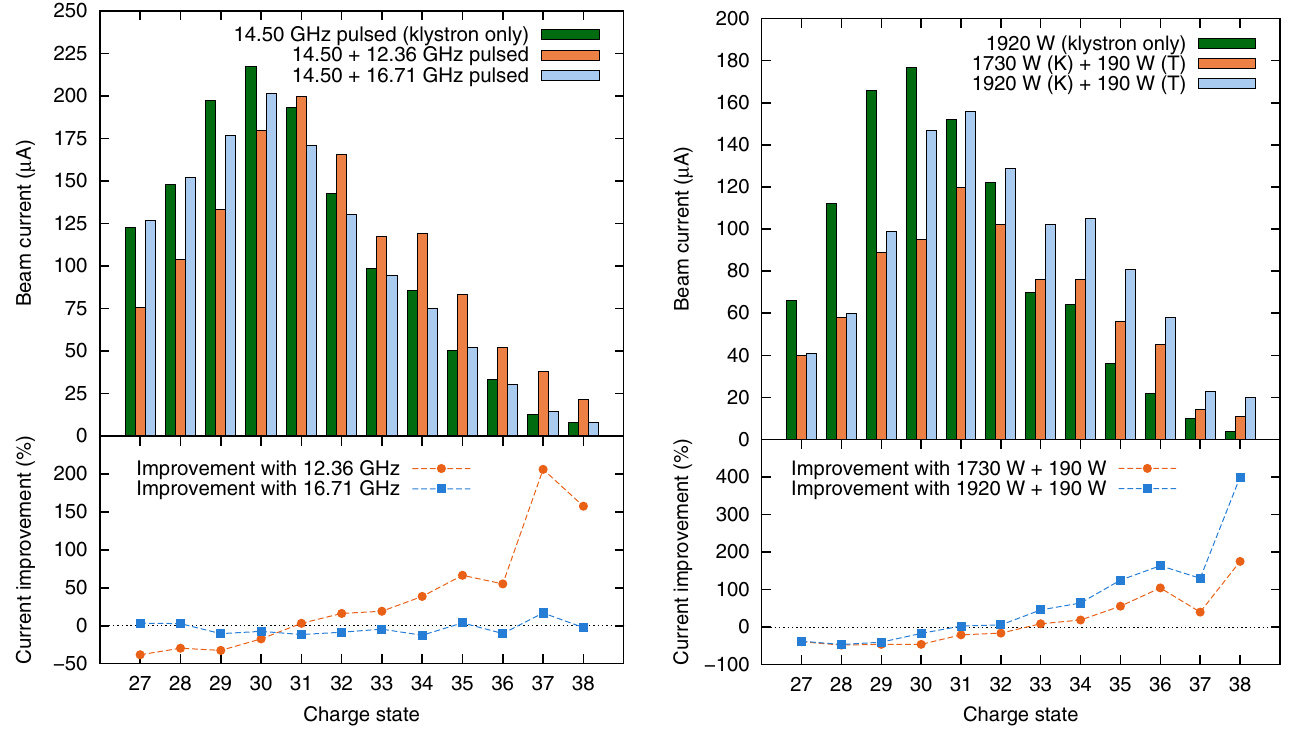
FIG. 10. Lead charge state distribution during afterglow with two different secondary microwave frequencies. Klystron operated at 1920 W, TWTA at 180 and 185 W for 12.36 and 16.71 GHz, respectively. Both microwave sources are pulsed at 10 Hz. Three cases are presented, (1) klystron only at 14.50 GHz, (2) klystron at 14.50 GHz with 12.36 GHz secondary frequency from TWTA, and (3) klystron at 14.50 GHz with 16.71 GHz secondary frequency. In addition the change in the beam current of different charge states with secondary frequency is presented (points connected with dashed lines).